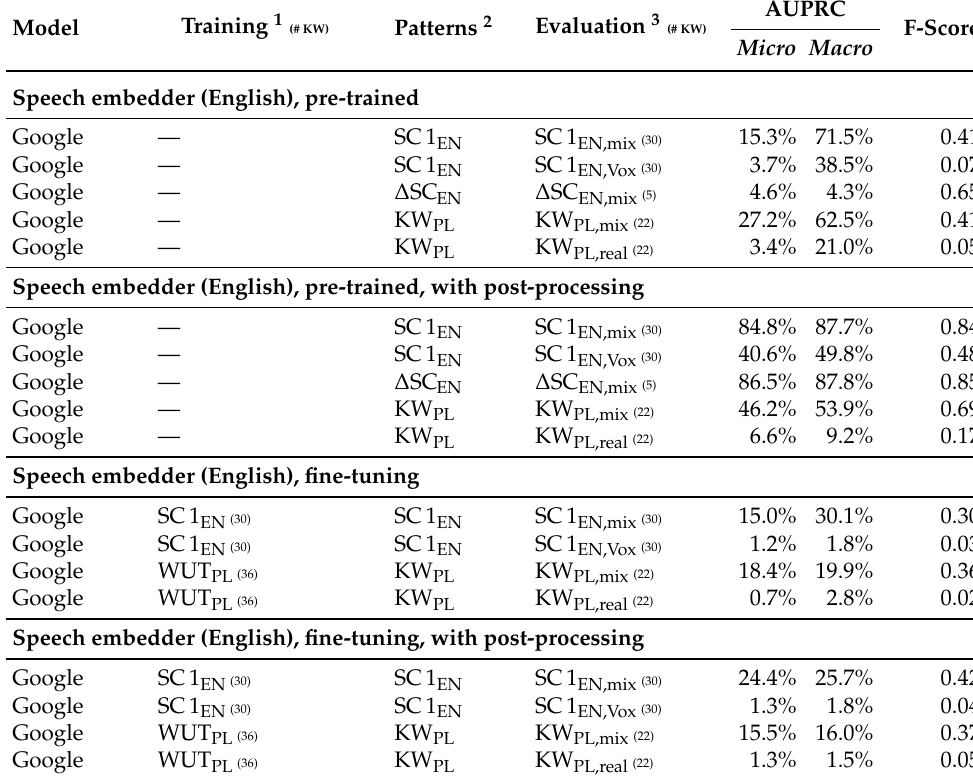
Table 6. Keyword detection performance for the pre-trained speech embedder. We use it either with default detection settings or with an additional post-processing procedure. We also compare the embeddings generated directly from the pre-trained model and from a model fine-tuned on selected datasets. Metric values are reported in the same manner as in Table